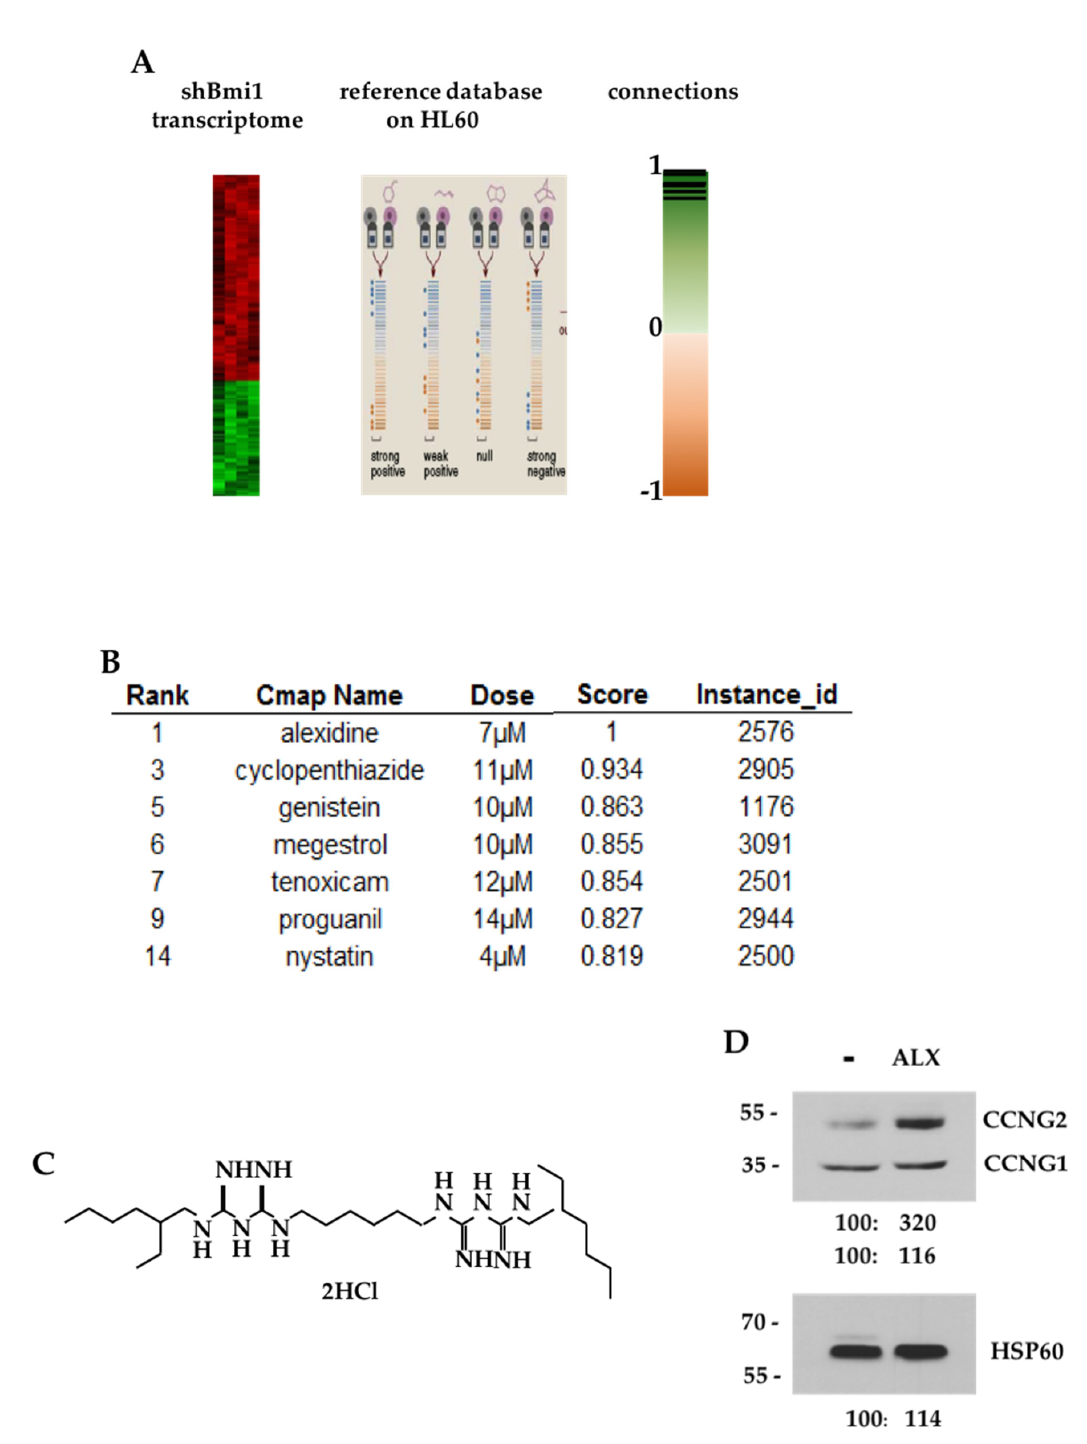
Figure 1. Alexidine was identified by bioinformatic analysis as the best candidate to mimic BMI1 silencing in K562 cells: ( A ) Strategy to identify new candidates mimicking BMI1 silencing in K562 cells among FDA-approved pharmacological molecules referenced in the Connectivity Map database. ( B ) Rankings and scores of ALX and some other molecules after CMAP analysis. ( C ) Structure of ALX. ( D ) K562 cells were incubated 6 h in the presence or absence of 10 μ M ALX. Cell lysates were analyzed by immunoblotting for the indicated proteins. Densitometry normalized to control are indicated.